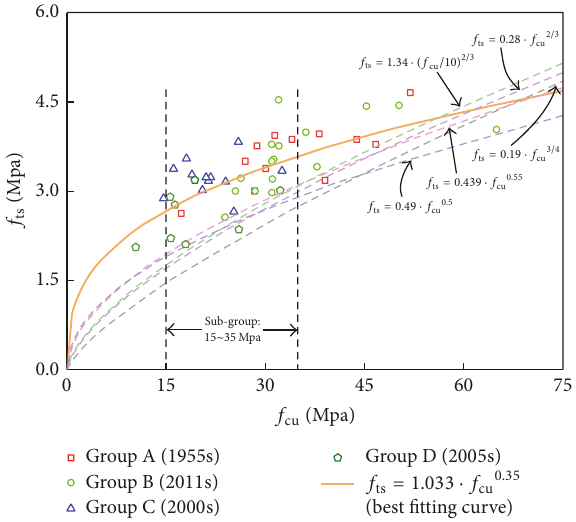
Figure 5: Compressive and splitting tensile